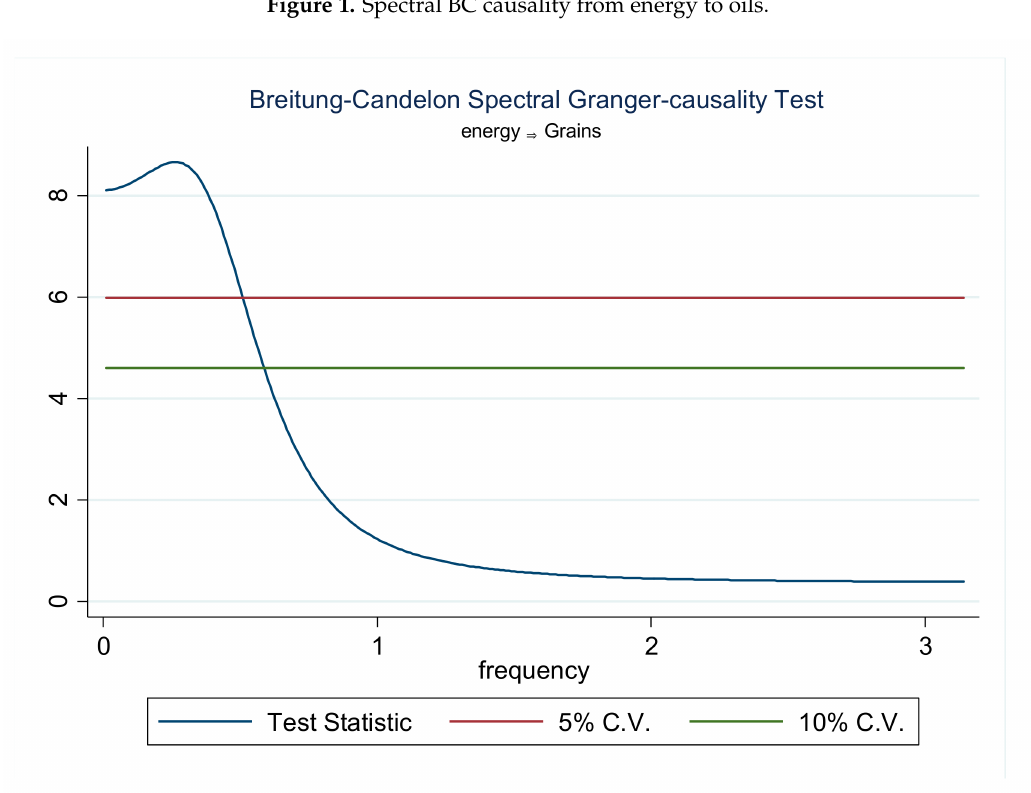
Figure 1. Spectral BC causality from energy to oils.